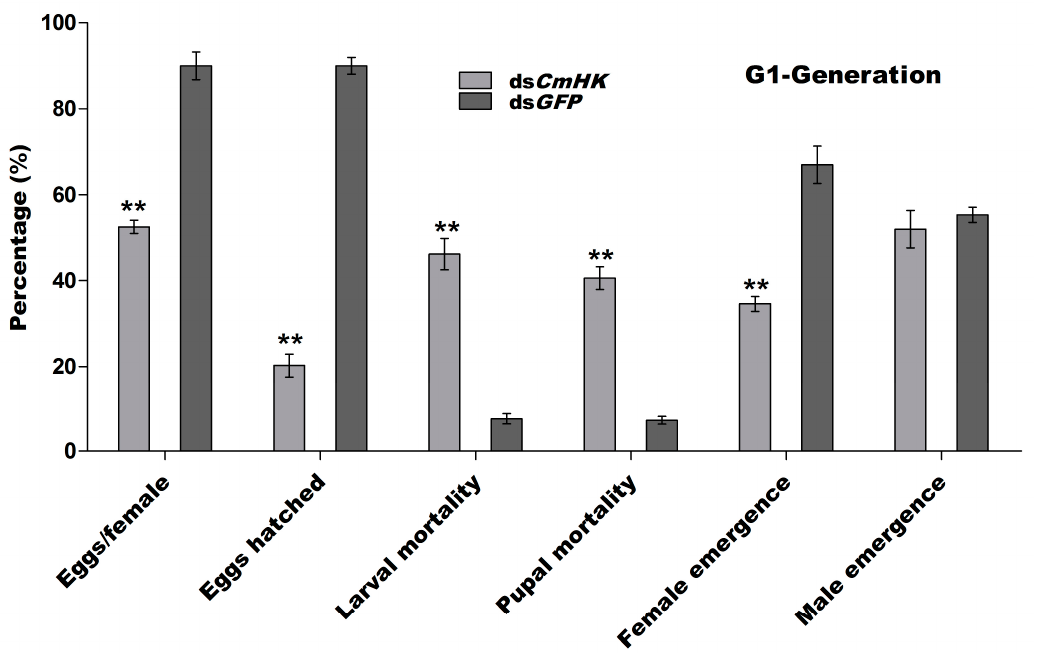
Figure 7. Percentage of eggs per female, eggs hatched, larval and pupal mortality, and male and female emergence rate in G1-generation of C . medinalis . Five pairs of male and female adults were selected for the G1-generation experiment. Each bar indicates the mean ± SD from the CmHK and GFP groups. Significant differences are indicated by ** ( P < 0.05).